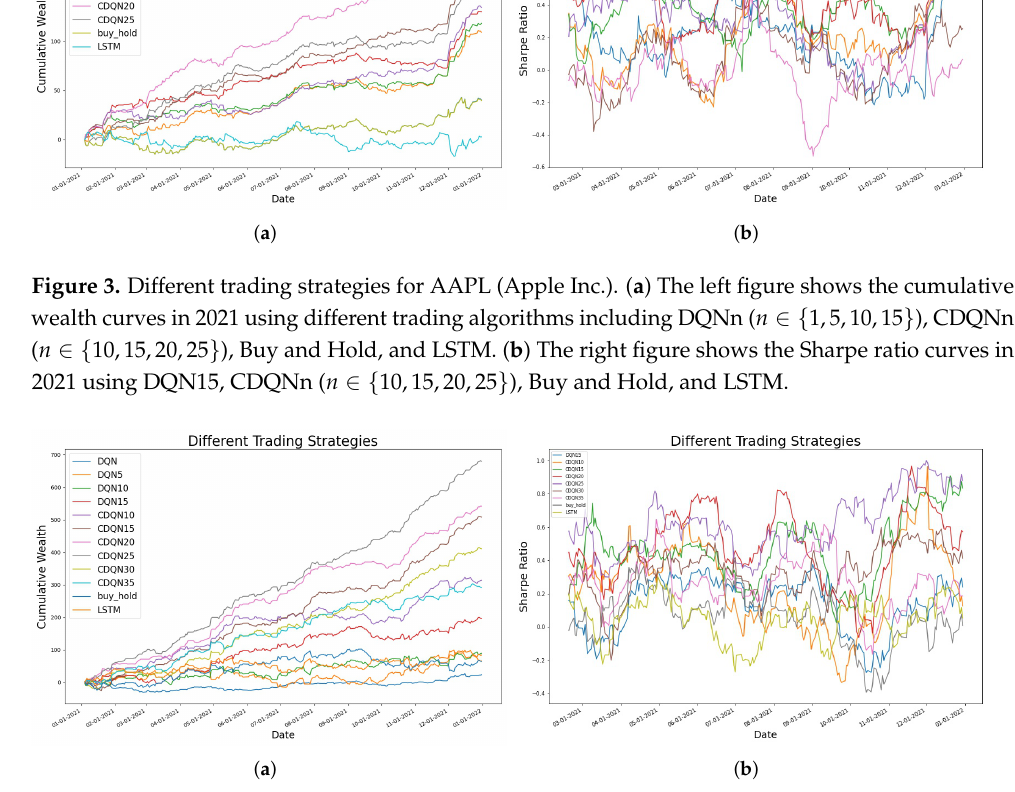
Figure 4. Different trading strategies for FB (Meta Platforms, Inc.). ( a ) The left figure shows the cumu- lative wealth curves in 2021 using different trading algorithms including DQNn ( n ∈ { 1,5, 10,15 } ), CDQNn ( n ∈ { 10,15,20,25,30,35 } ), Buy and Hold, and LSTM. ( b ) The right figure shows the Sharpe ratio curves in 2021 using DQN15, CDQNn ( n ∈ { 10,15,20,25,30,35 } ), Buy and Hold, and